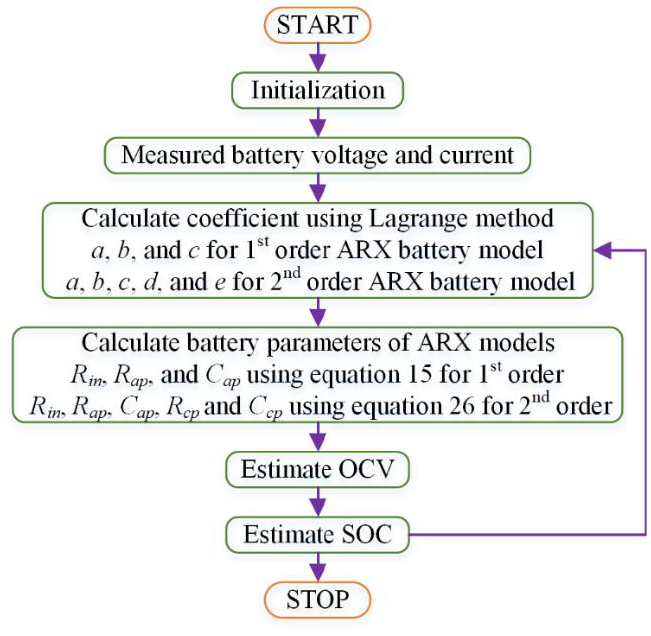
Figure 3. Flow diagram for OCV and SOC estimation.